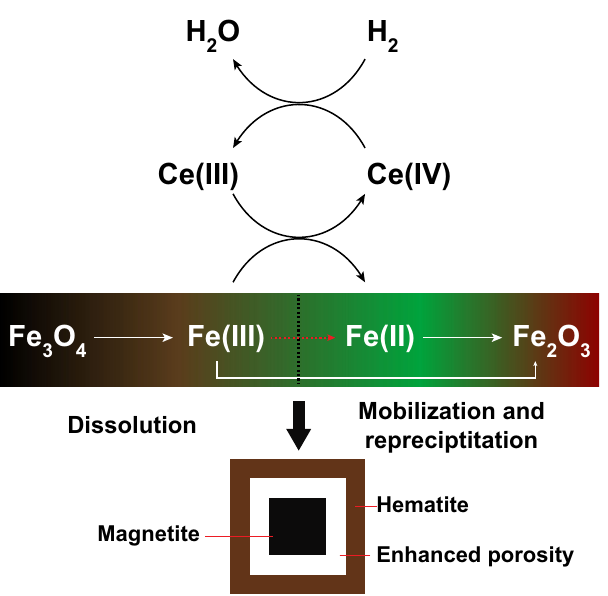
Fig. 3 Fe(III)-Fe(II) and Ce(III) – Ce(IV) reaction cycles. The presence of Ce(III) affects the Fe(III) – Fe(II) interconversion and contributes to enhanced porosity at magnetite – hematite interface.